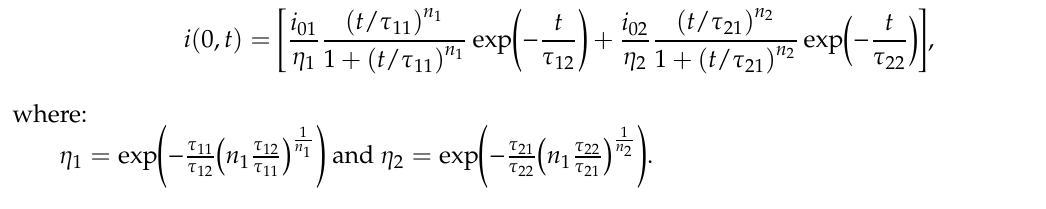
Table 1. The basic parameters for the channel base current function.